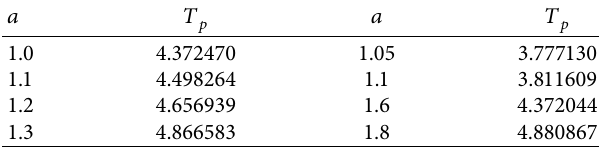
Table 4: Periods T p of cycle 12 and cycle 2 in the Rucklidge system for different a